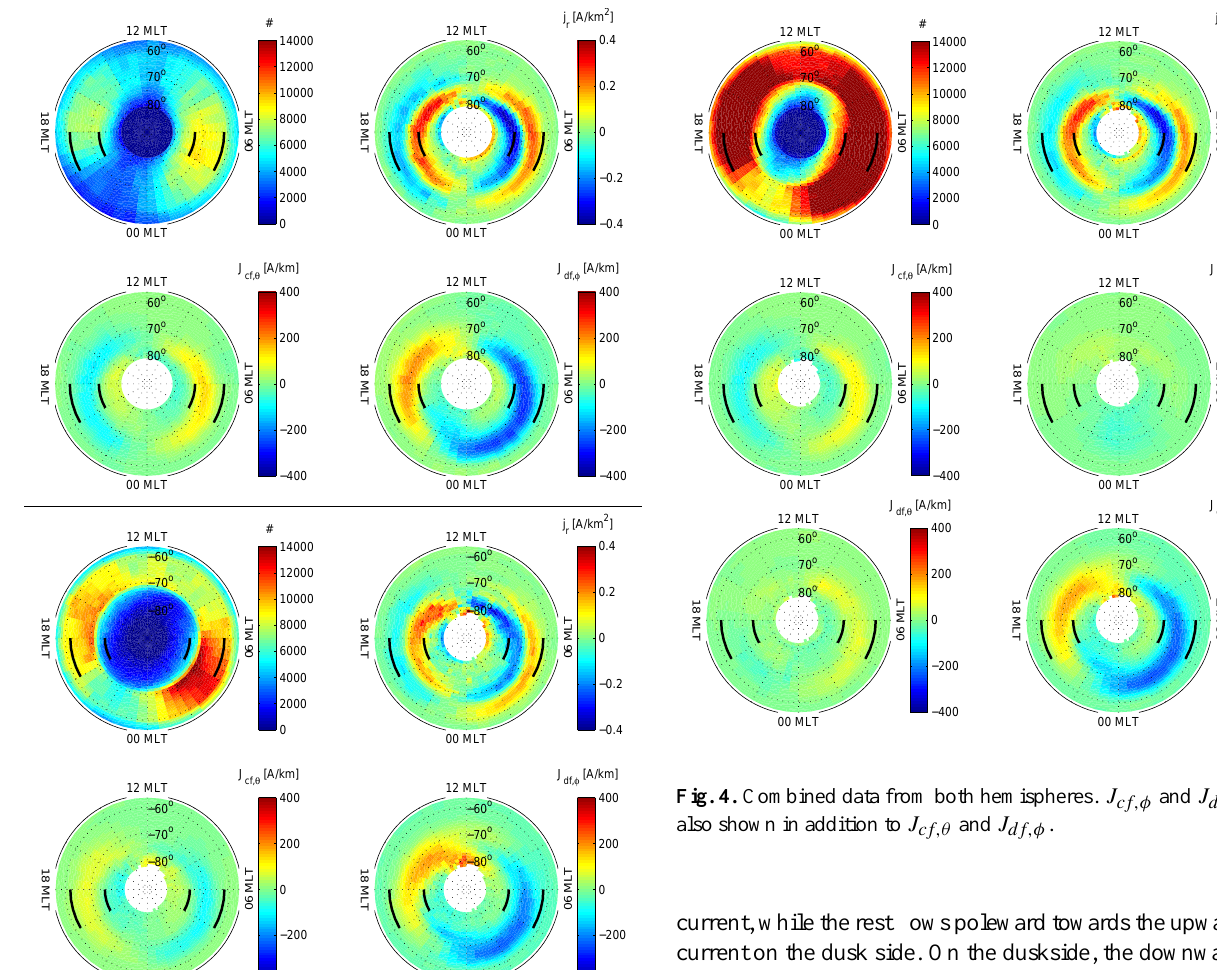
current, while the rest flows poleward towards the upward R1 current on the dusk side. On the duskside, the downward R2 current flows towards the upward R1 current. The antisun- ward electrojets in the dawn and dusk sectors of the auroral oval and the sunward return current across the polar cap